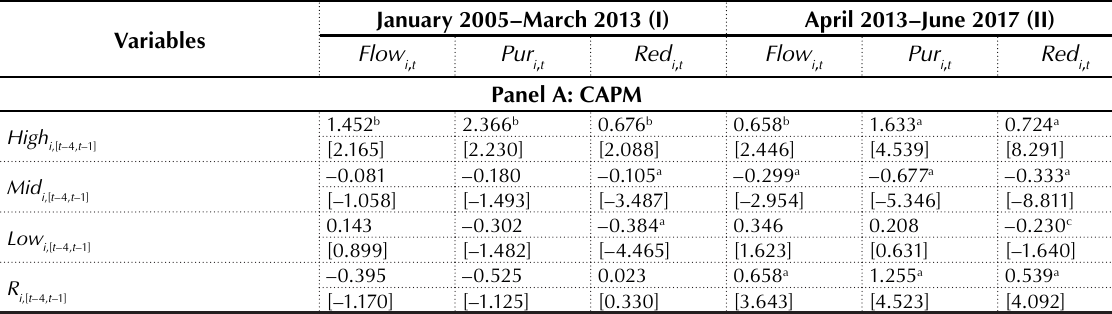
Table 6. Robustness test on two subperiods: CAPM alpha and four-factor